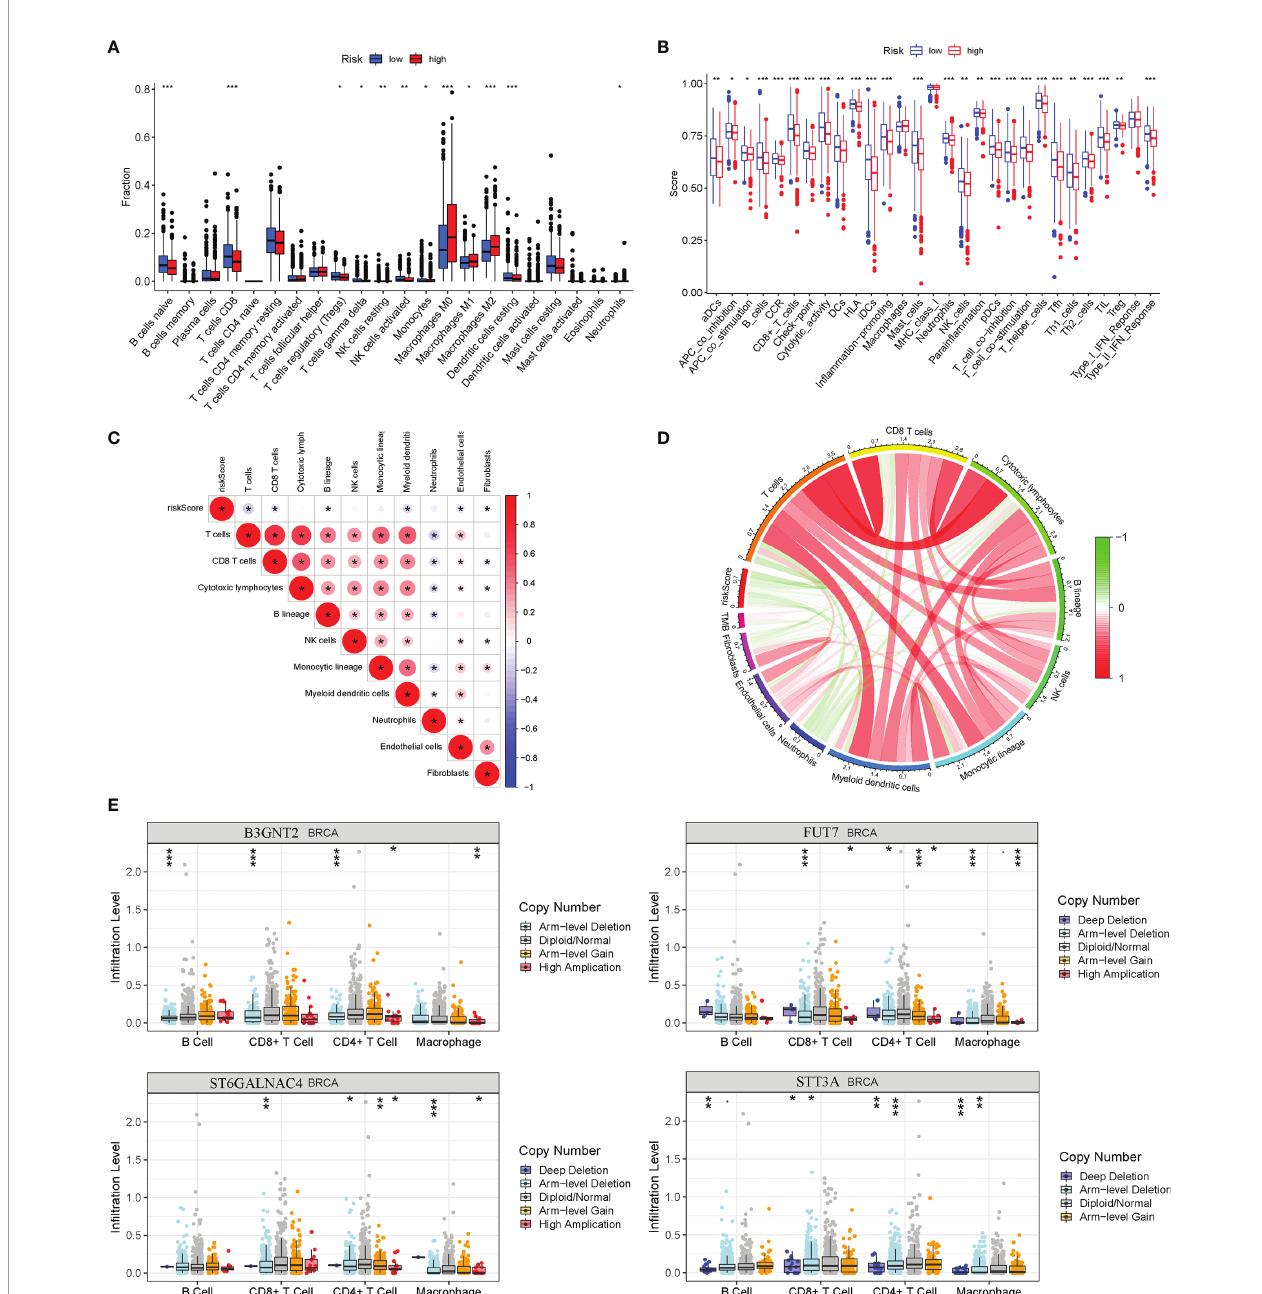
FIGURE 8 | Relationship between risk model and immune status in the high-risk and low-risk groups. (A) Differential immune in fi ltrates of 22 immune cell types. (B) Twenty-nine related immune pathways. (C) Correlation matrix of the relationship between risk score and differential immune in fi ltration levels. (D) The circular plot of the relationship between the risk score and immune in fi ltration levels. Green represents the negative association, and red represents the positive association. (E) Relationship between copy number variation of 4 glycosyltransferase genes in the signature and immune in fi ltration level in BC. BC, breast cancer. *p < 0.05, **p < 0.01, ***p <